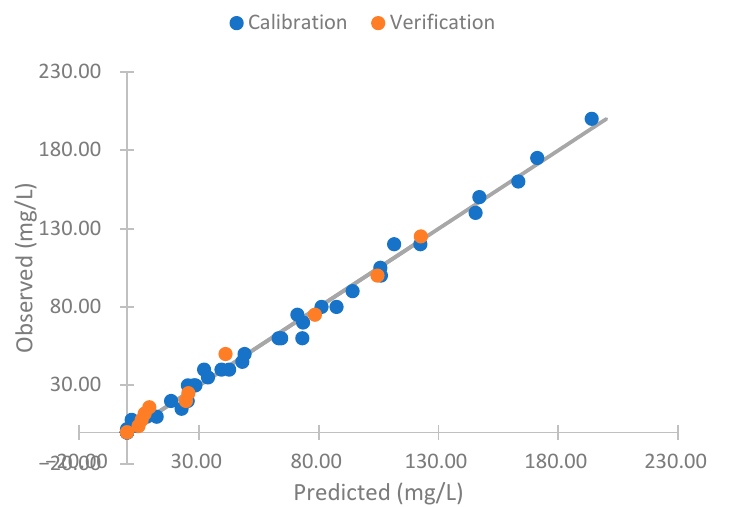
Figure 18. Observed vs. predicted Equation (7).